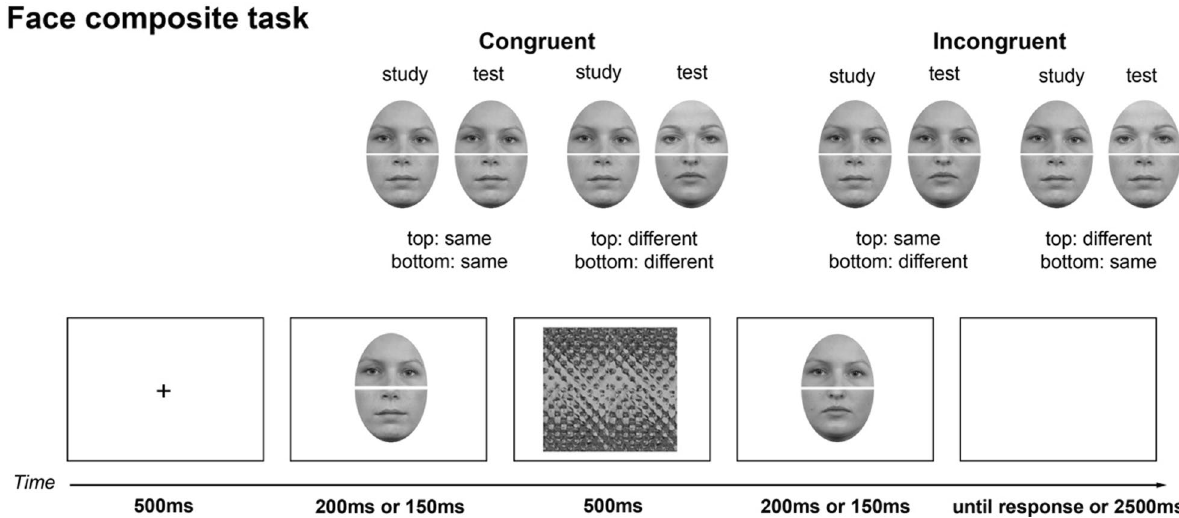
Fig. 1 Task design and sample trial sequence of the face composite task (not actual stimuli used in the experiment due to copyright issues; the sample faces were taken from the Radboud Faces Database, Langner et al., 2010). In this task, the face composites were always aligned. The relationship between the top and bottom halves of the study and test faces could be either congruent or incongruent. To improve reliability of the measure by increasing variability in task difficulty (Wang et al., 2016), the faces were shown for 200 ms in the first half of the study and for 150 ms in the second half of the